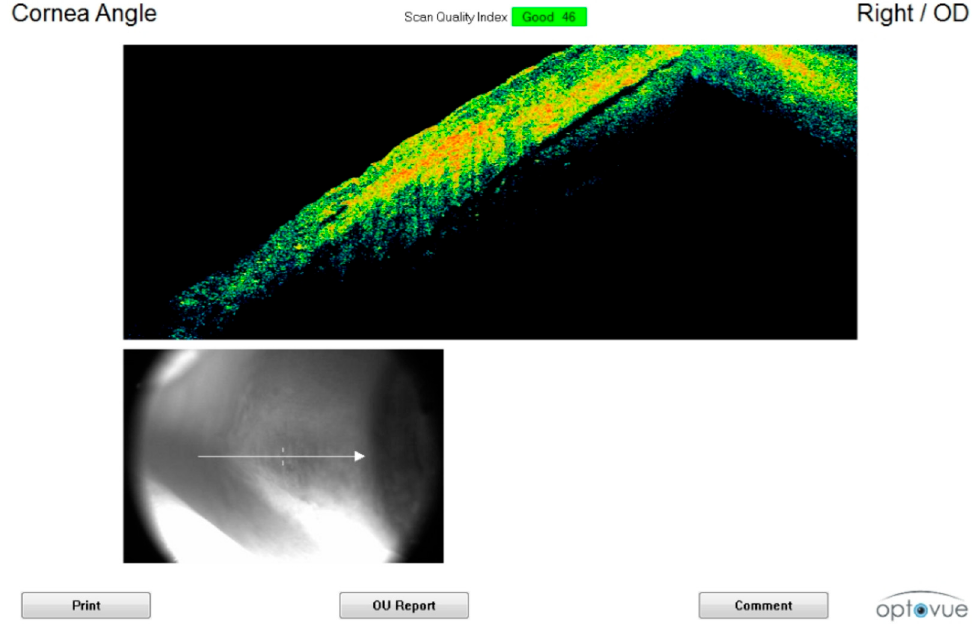
Figure 5. OCT image of postmortem tache noir. Scleral surface hyper-reflectivity and separation between the sclera and choroid.